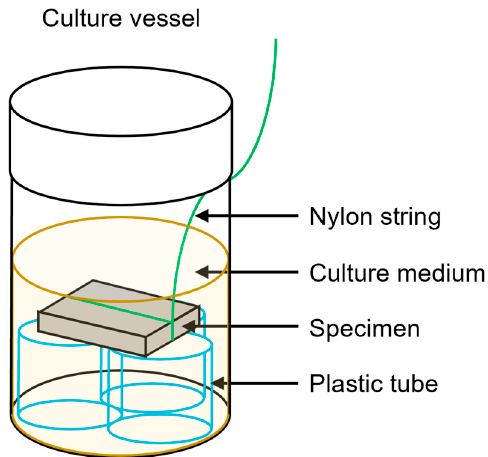
Figure 1. Schematic drawing of the experimental apparatus.